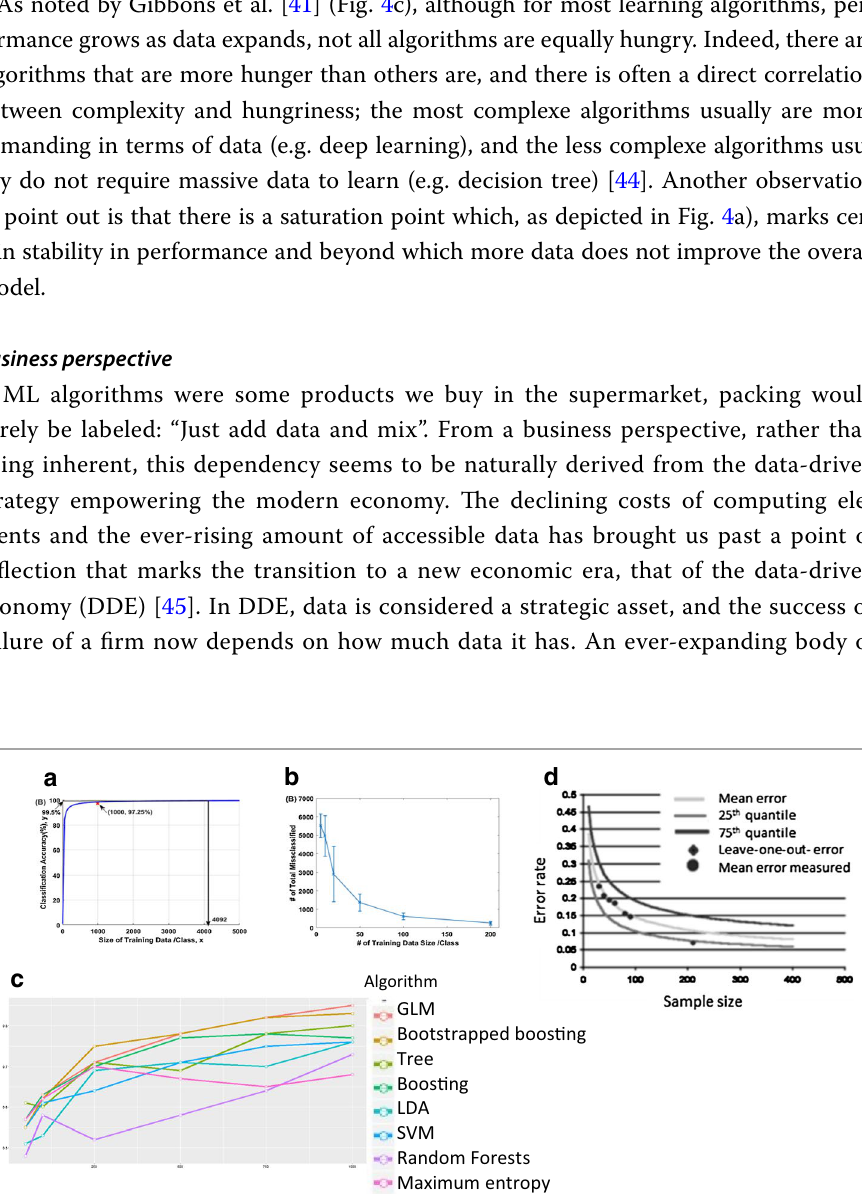
Fig. 4 Examples of learning curves. a Learning curve of medical image classification using differing sample size [42], b The number of misclassified medical images on the whole body in an increasing number of training data sets [42], c Algorithm performance with increasing training sample sizes and differing algorithms [41], d Learning curve in the tumor versus nontumor classification constructed using differing sample size